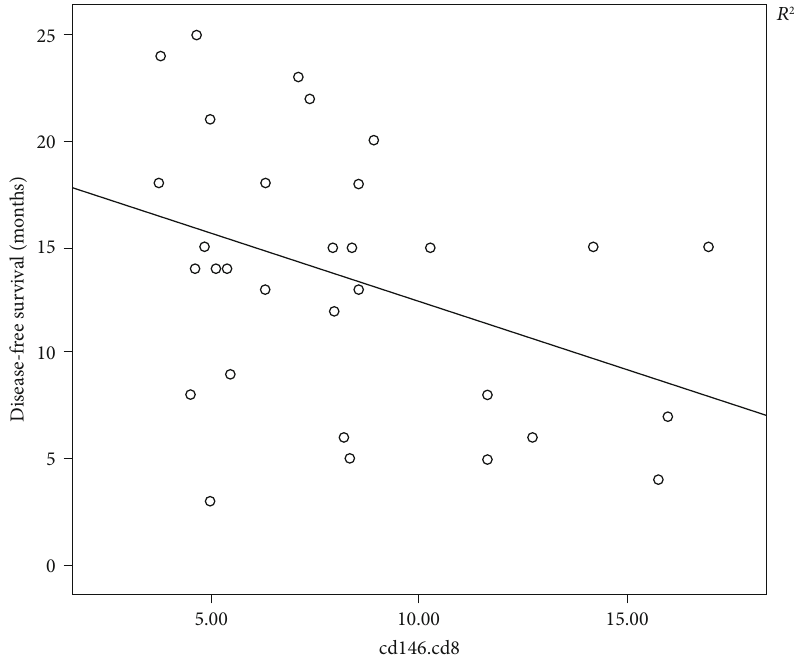
Figure 7: Scatter plot of the relation between CD146 + CD8 + cells and DFS.